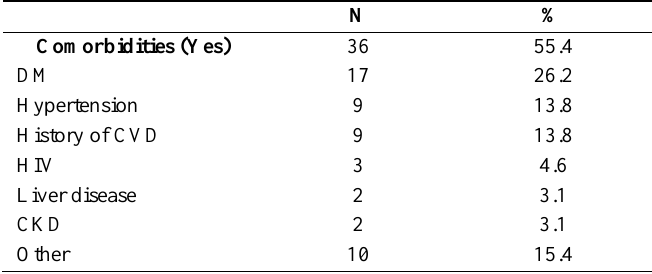
Table 2 : The co morbidities among severe malaria patients